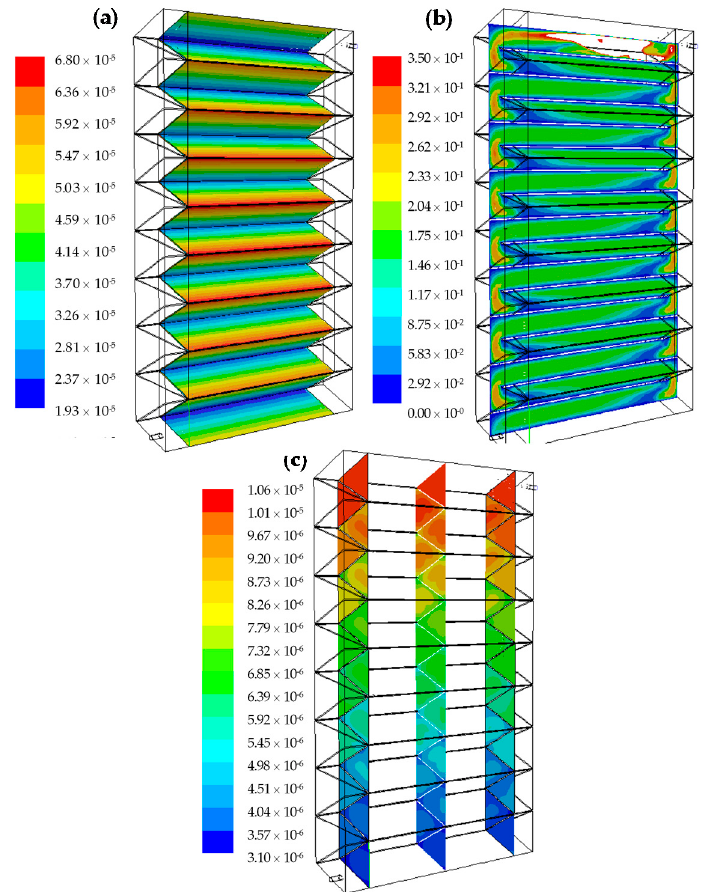
Figure 5. ( a ) LSRPA on the corrugated plate (einstein m − 2 s − 1 ); ( b ) contours of velocity (m/s) in the central plane of the reactor; and ( c ) contours of molar HCHO fractions.